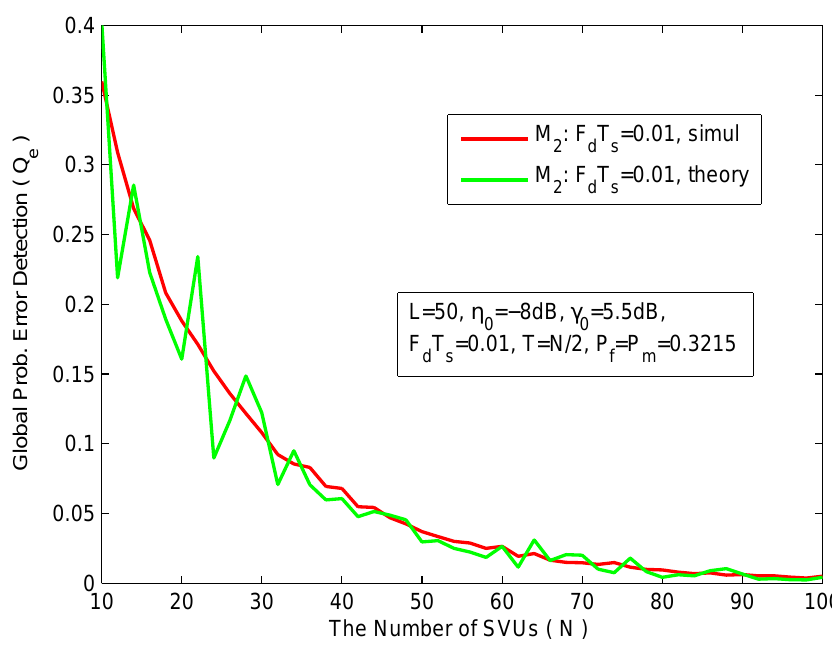
Figure 10. The global probability of error detection as a function of the number of